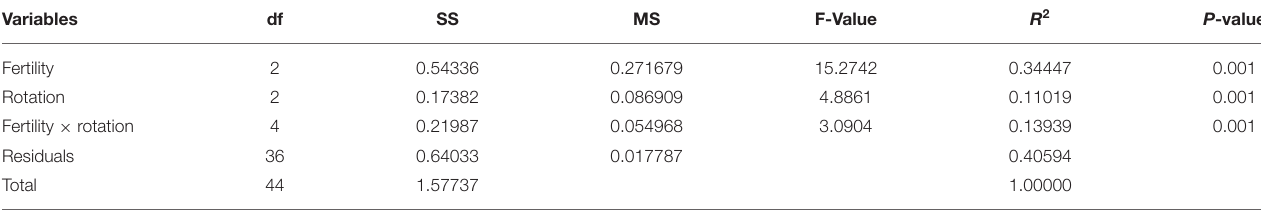
TABLE 4 | Permutational analysis of variance (PERMANOVA) table. Variables df SS MS Fertility